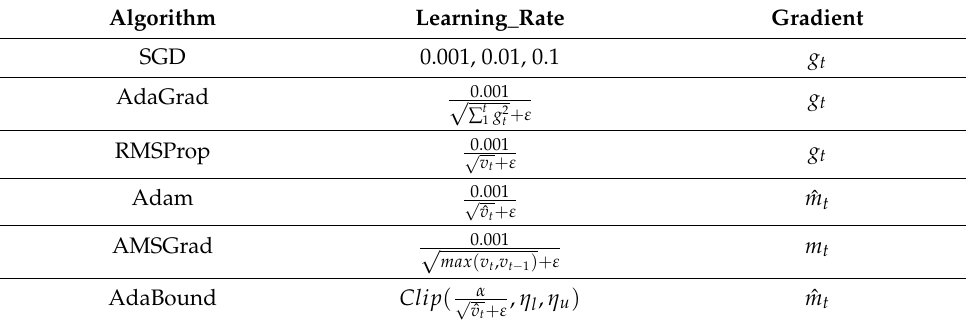
Table 1. Differences and similarities between gradient descent